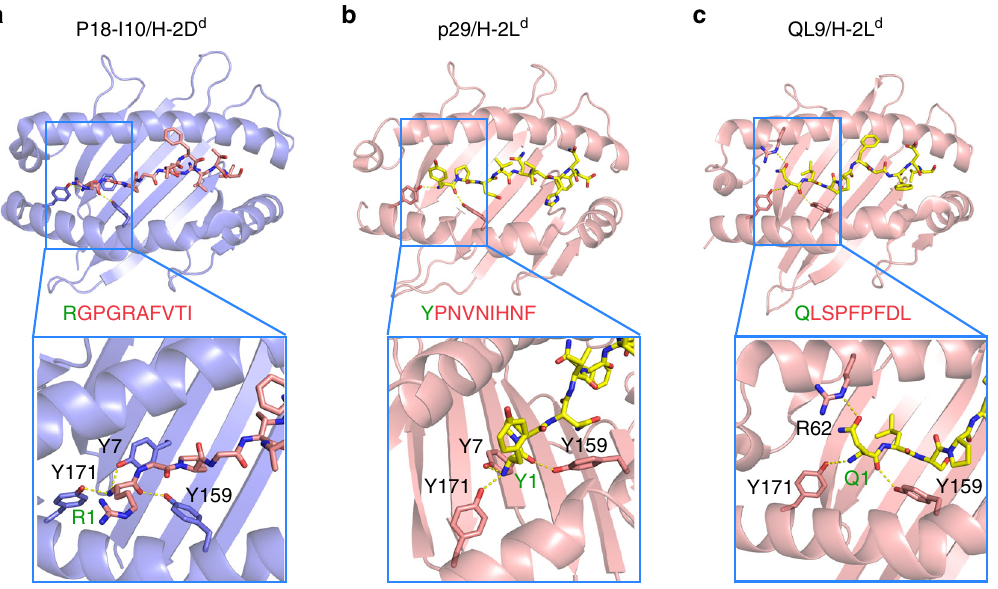
Fig. 2 Structure-guided design of placeholder peptides for murine MHC-I molecules. Crystal structures showing stabilizing contacts in the A-pocket of the MHC-I peptide-binding groove for: a P18-I10/H-2D d (PDB 3ECB 1 ) with the bound peptide shown in light red. b Structure of p29/H-2L d (PDB 1LD9 2 ), and QL9/H-2L d (PDB 3TF7 3 ), with bound peptides shown in yellow. Insets focus on the A-pocket of the MHC-I peptide binding groove, with polar contacts between the N-terminal residue of the peptide and the indicated MHC-I residues shown as dotted yellow lines. Full peptide sequences are provided, with the fi rst residue indicated in